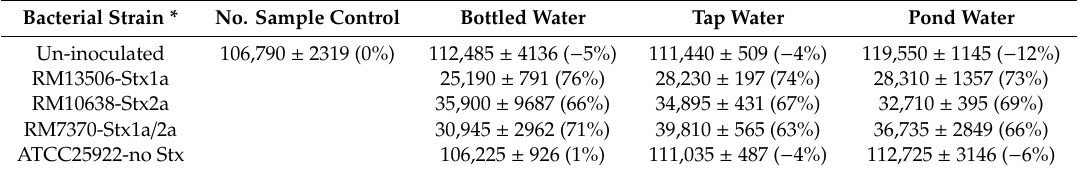
Table 3. Detection of Stx cytotoxicity in water samples inoculated with bacteria. Bacterial Strain *